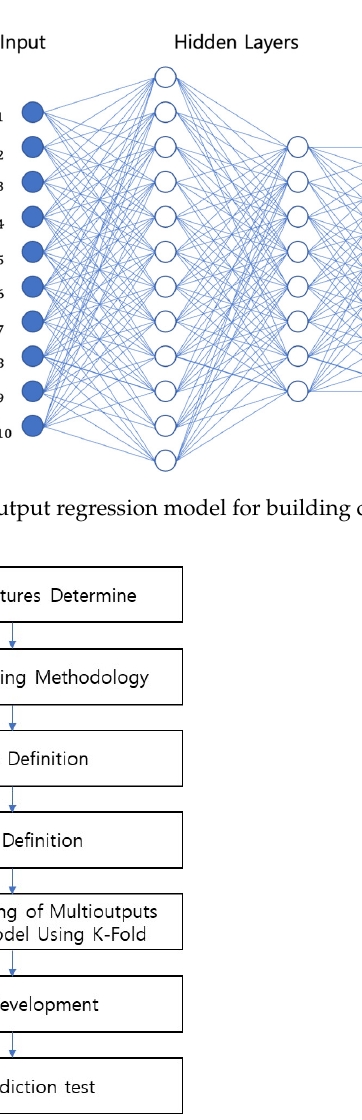
Figure 2. Multioutput Regression Machine Learning Analysis